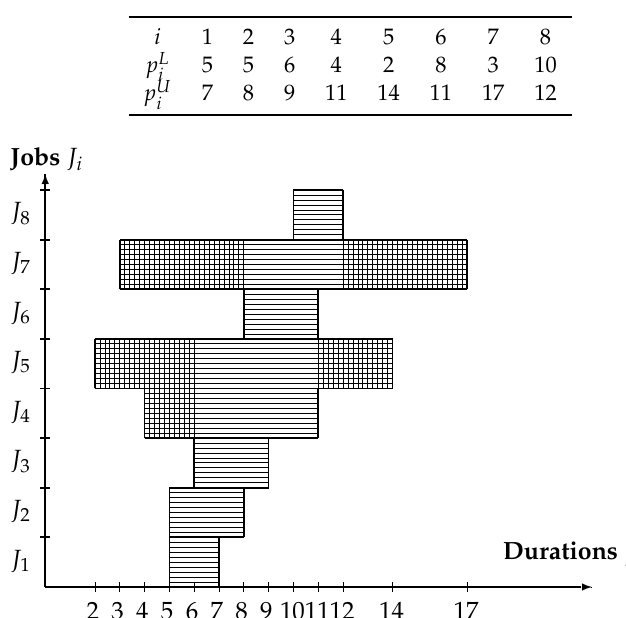
≤ p ≤ p U | ∑ C i i . i i